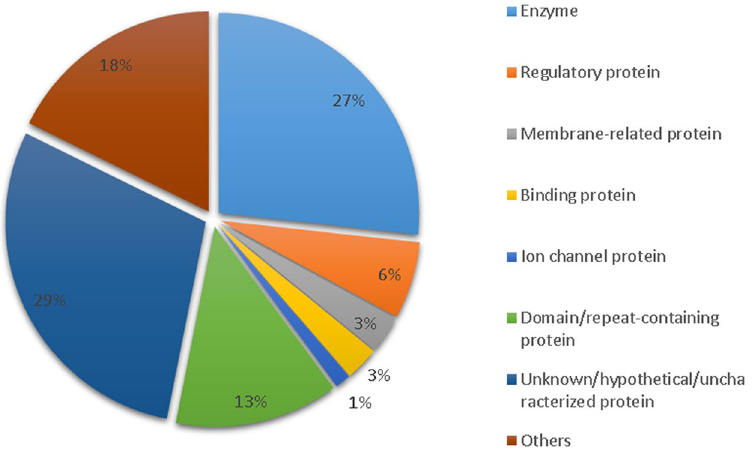
Figure 5. Functional classification of interacting mRNAs targeted by 29 lncRNAs from P . caribaeorum . Functions of target mRNAs were extracted based on the annotation information of BLAST alignment